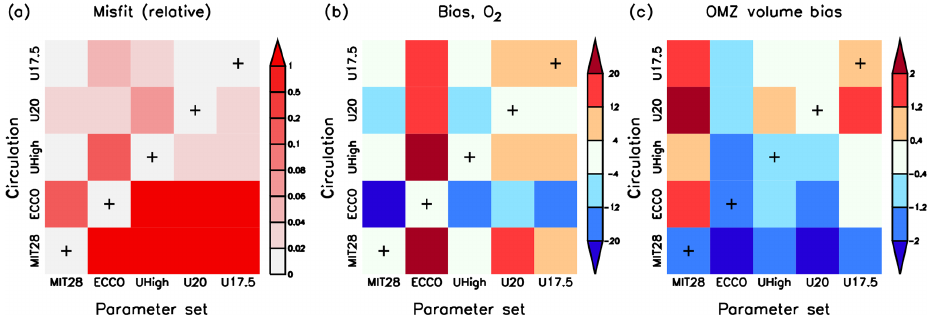
Figure 7. Three different model diagnostics for all cross-validation experiments with parameter set i and circulation j : (a) normalised misfit − 1, where J ∗ J i,j /J ∗ is the lowest misfit for each circulation j . (b) Oxygen bias (model minus observation, mmolm − 3 ). (c) OMZ volume j j (as percent of total ocean volume) bias. OMZs are defined by 50mmolm − 3 . The x axis denotes the optimal parameter sets of MIT28 ∗ , ECCO ∗ , UHigh ∗ , U20 ∗ and U17.5 ∗ and the y axis the circulation. Pluses along the main diagonal indicate the optimal model simulation for each circulation ( i = j ), i.e. MIT28 ∗ , ECCO ∗ , UHigh ∗ , U20 ∗ and U17.5 ∗